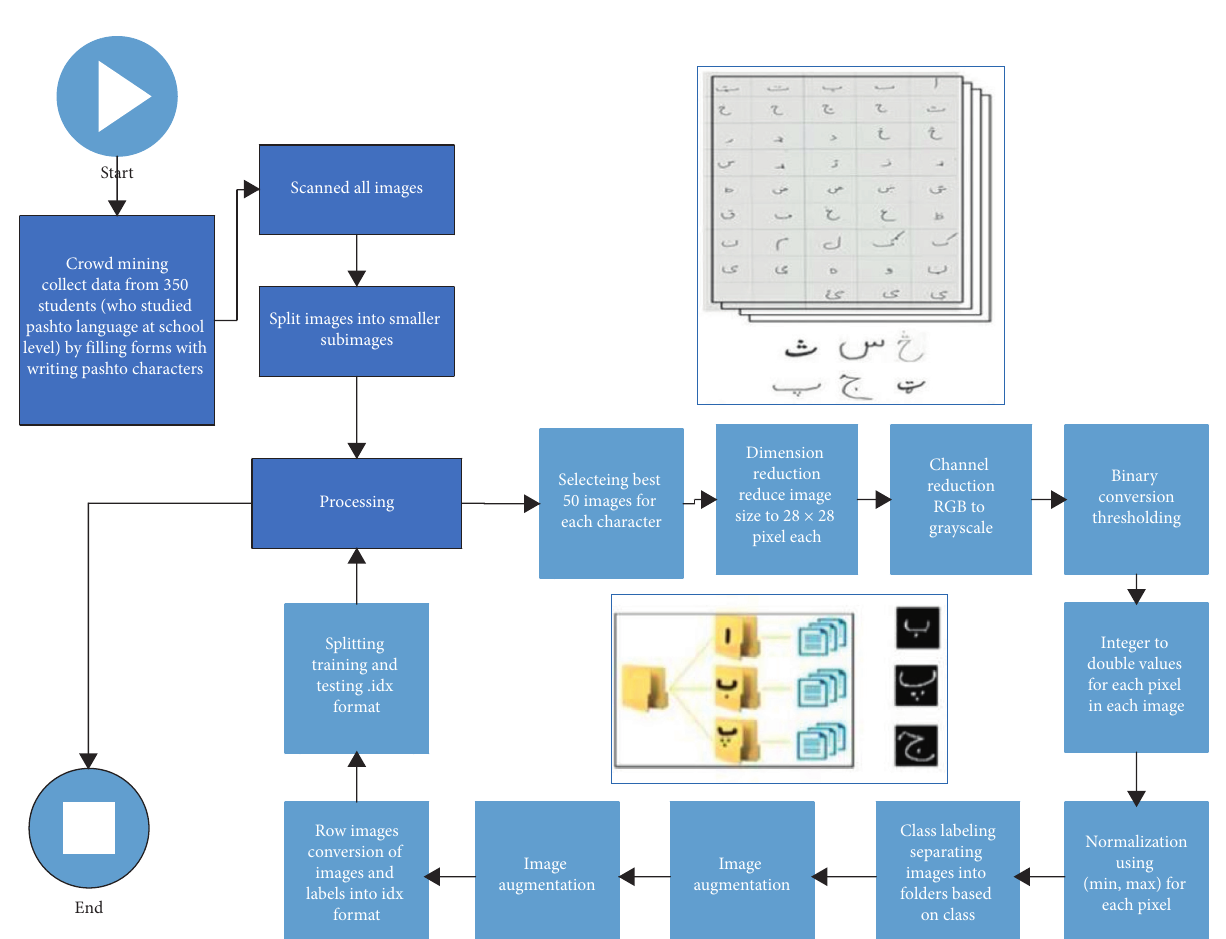
Figure 1: Research methodology flow